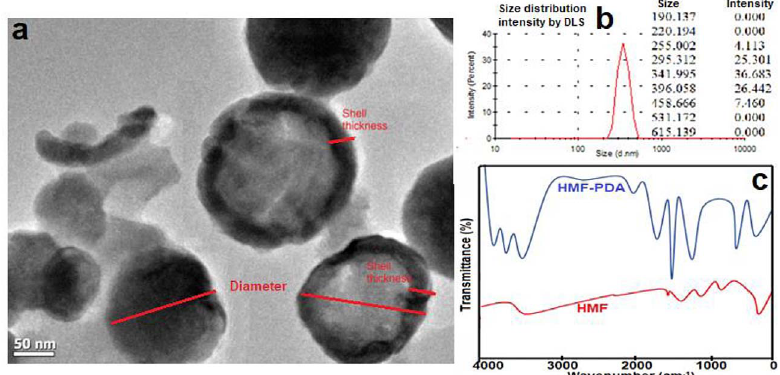
Fig. 3. (a) TEM results of HMF NPs, (b) DLS size distribution of HMF-PDA NPs, (c) FTIR spectra for bare HMF (red) and HMF-PDA (blue).